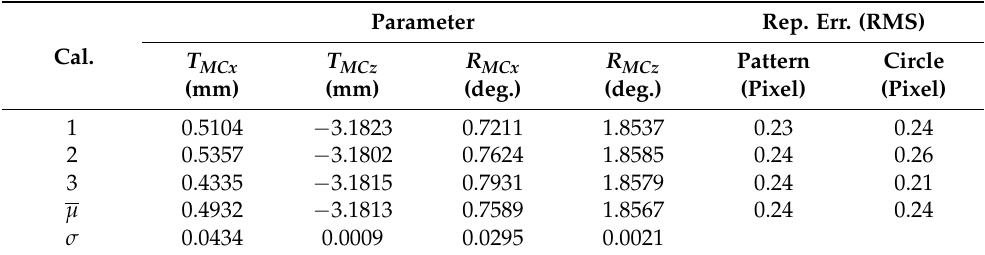
Table 7. Results for three independent calibration experiments (left eye).